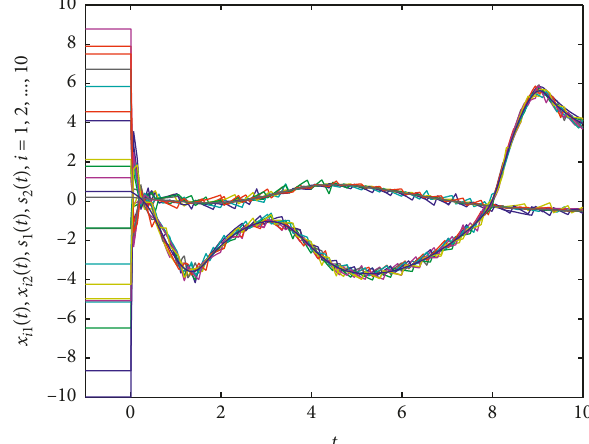
( t ) , x ( t ) , and s ( t ) i 1 i 2